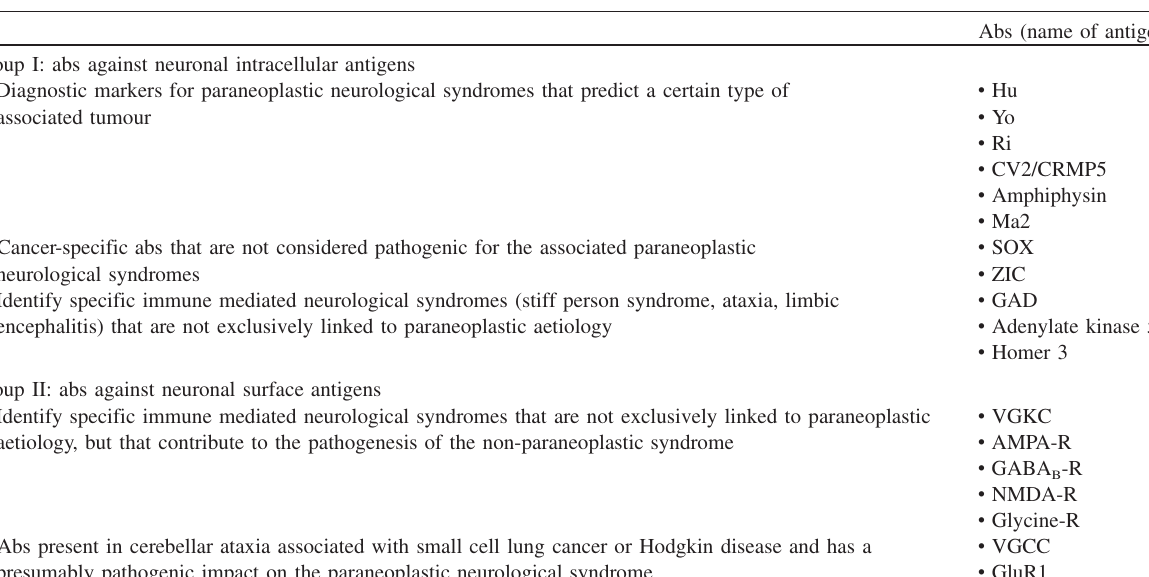
Table 1 Classification of antineuronal